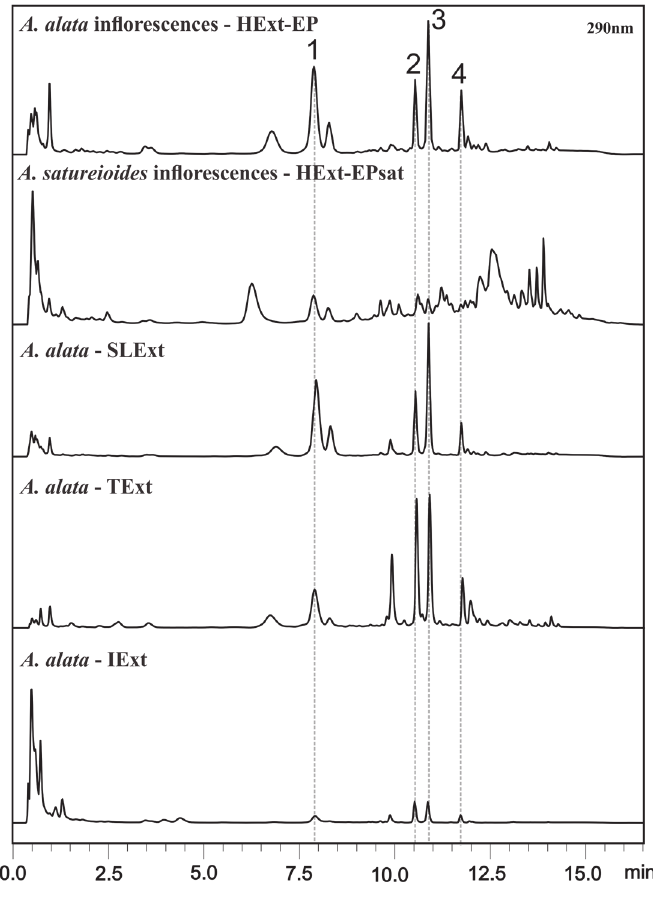
Fig 4. Chromatograms HPLC-DAD of HExt-EP, HExt-EPsat, SLExt, TExt and HExt at 290 nm. The compounds Gnaphaliin, Lepidissipyrone, Helipyrone e Obtusifolin is indicated by the numbers 1, 2, 3 and 4,